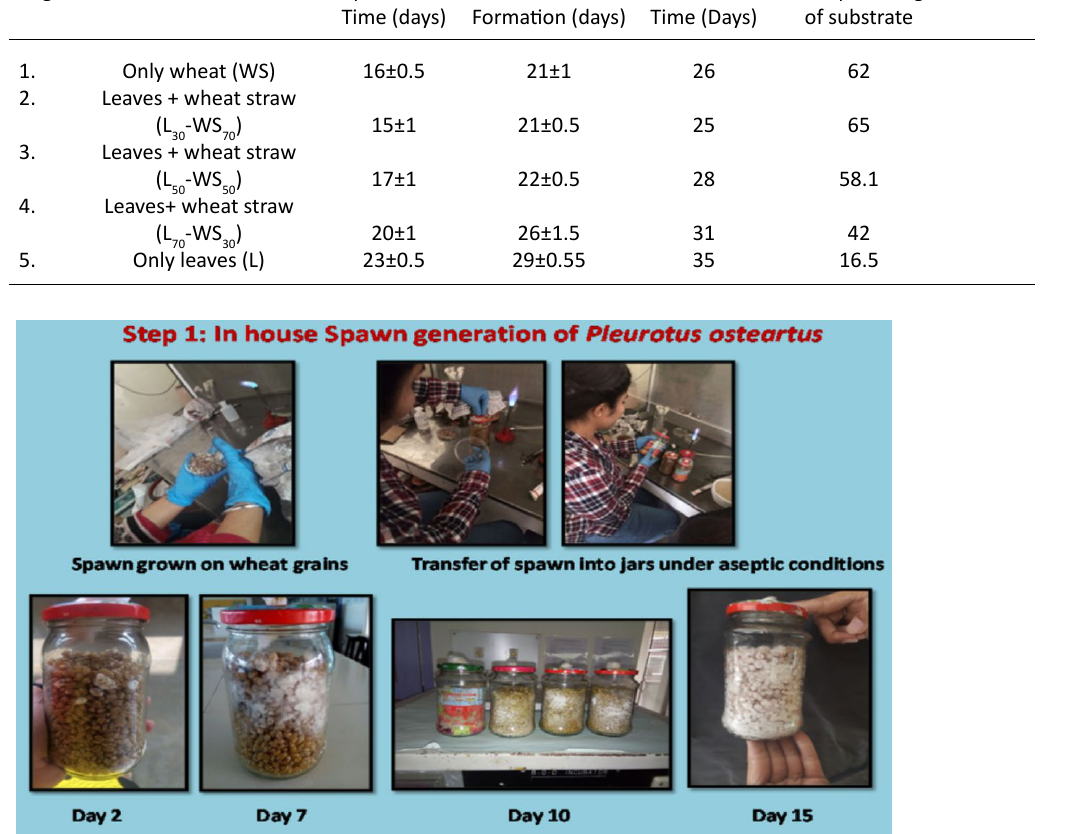
Fig. 2. In house spawn generation in glass jars on wheat grains